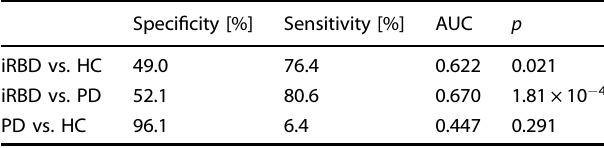
Fig. 6 Calibrated sFIDA results and receiver operating characteristic (ROC) analyses for detecting α -synuclein aggregates in stool samples. Median concentrations of α -synuclein aggregates in stool samples of iRBD patients (9.2 fM) were signi fi cantly elevated compared to those of healthy controls (HC, 5.2 fM, p = 0.024) or PD patients (3.8 fM, p < 0.001). PD patients did not signi fi cantly differ from healthy controls. Box plots indicate the lower (Q1) and upper (Q3) quartiles as boxes. Horizontal lines within boxes indicate medians. Whiskers indicate 1.5 times the interquartile range (Q3 – Q1) above Q3 and below Q1. Data falling outside this range are plotted as outliers. Signi fi cant differences between groups were calculated using the Kruskal – Wallis H test. *** p < 0.001, **0.001 ≤ p < 0.01, *0.01 ≤ p < 0.05. Error bars indicate standard deviation. b In the ROC analyses, discrimination of PD patients versus healthy controls showed a speci fi city of 96.1% and a sensitivity of 6.4%, with an area under the curve (AUC) of 0.447. In comparison, discrimination of iRBD patients versus healthy controls showed a speci fi city of 49.0% and a sensitivity of 76.4% with an AUC of 0.622 (see Table 2 for other speci fi city and sensitivity values and signi fi cances). Table 2. Results of the ROC analyses for speci fi city, sensitivity, and area under the curve with the respective p-value for α -synuclein aggregates in